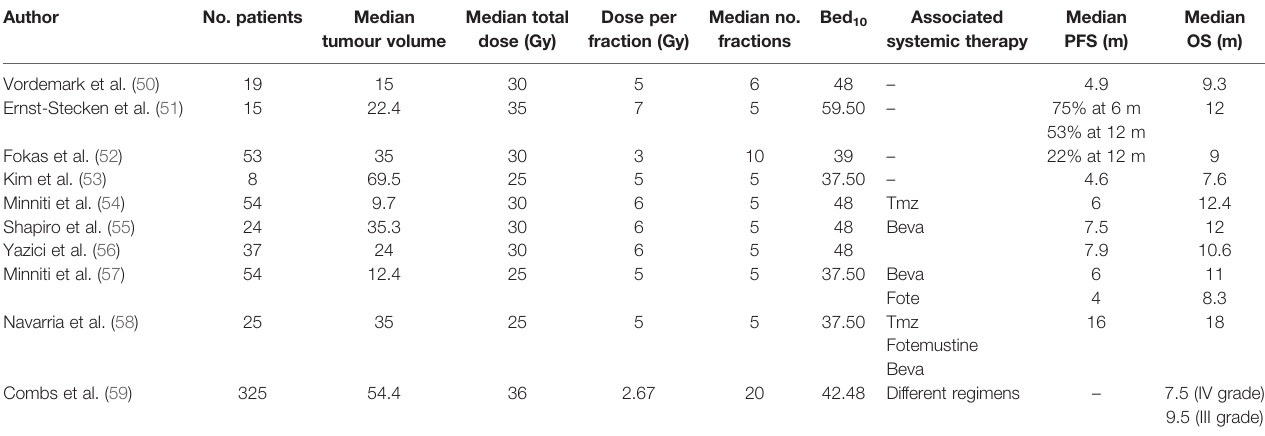
TABLE 4 | Studies on HSRT for recurrent high-grade